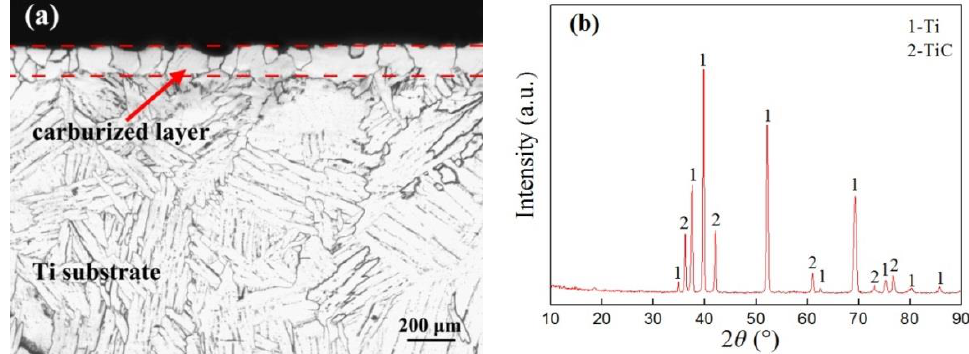
Figure 4. Cross-sectional metallographic image ( a ) and X-ray diffraction (XRD) pattern ( b ) of the carburized layer on the pure Ti substrate.